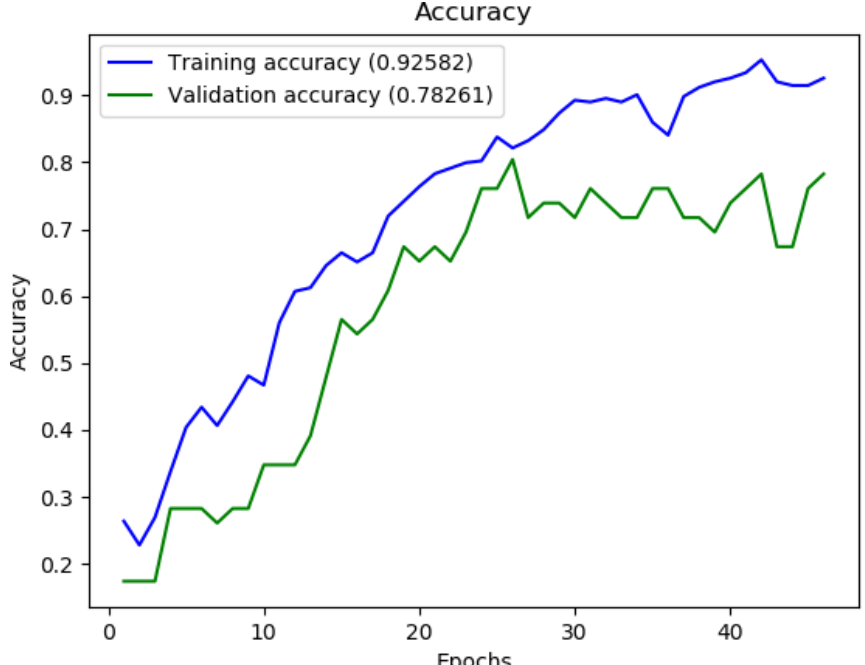
Figure 1. Accuracy graph of the network in [21], trained with the CK+ database using the data augmentation and the z-score normalization. Figure from [35].